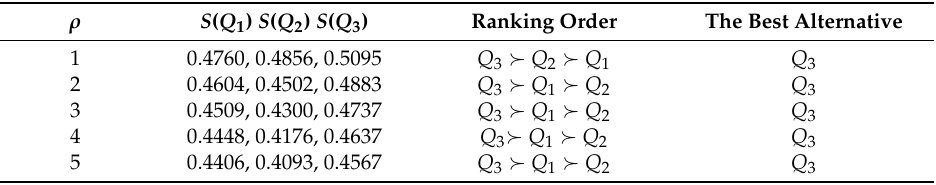
Table 4. Ranking results of the NCDWGA operator for different operational